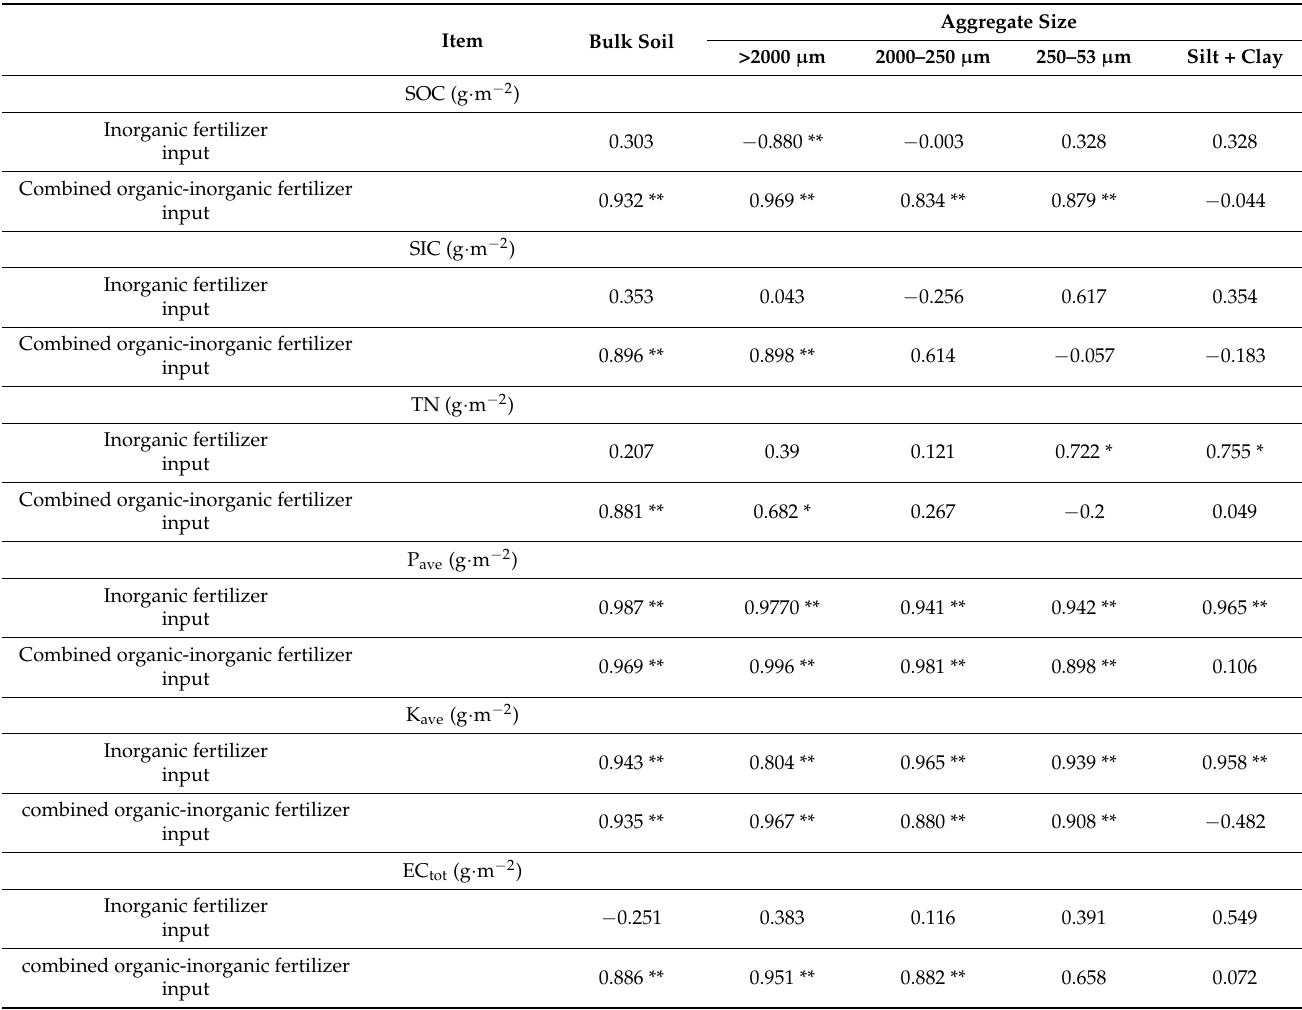
Table 4. Relationship between fertilizer input and soil nutrient stocks within aggregate fractions under 15 years of long-term fertilization. Aggregate Size Item Bulk Soil >2000 µ m 2000–250 µ m 250–53 µ